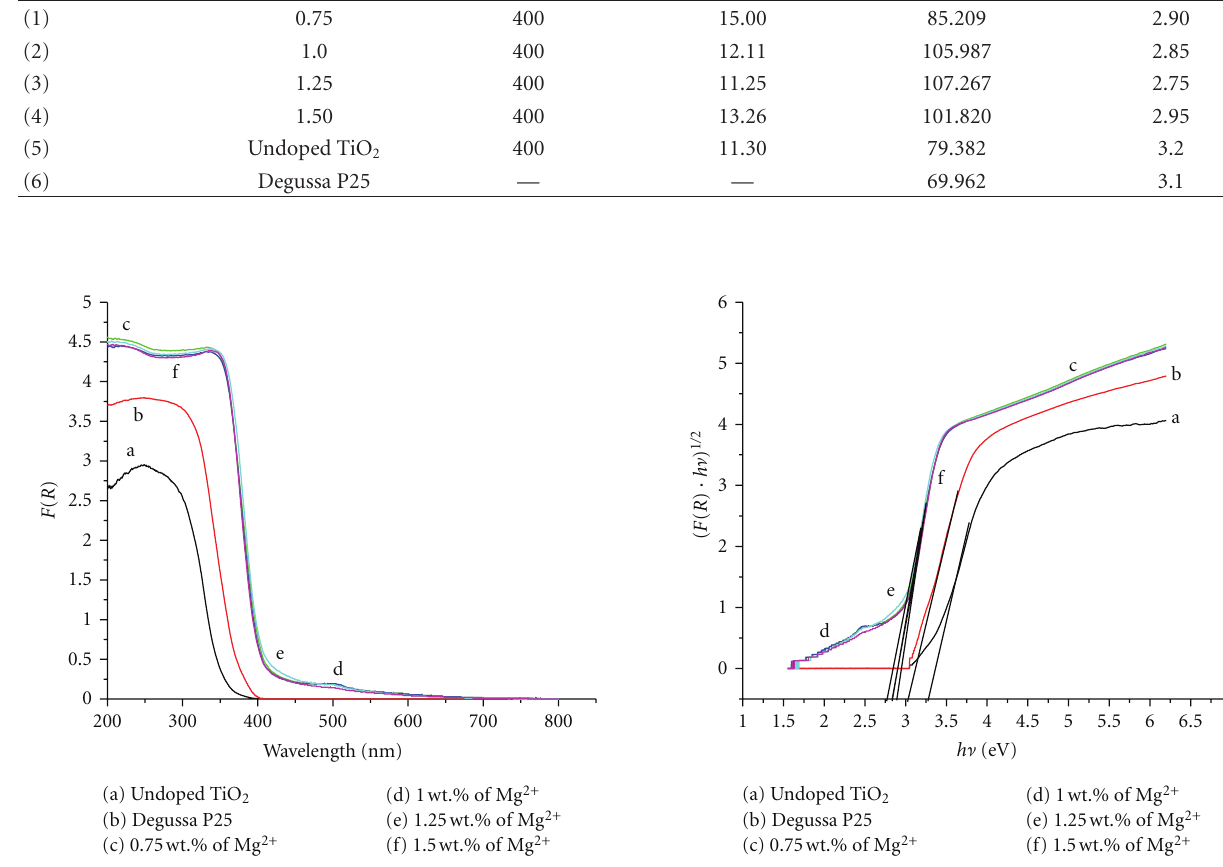
Figure 2: The DRS-UV-Vis spectra of Degussa P25, undoped, and doped TiO 2 with di ff erent % of Mg 2+ .